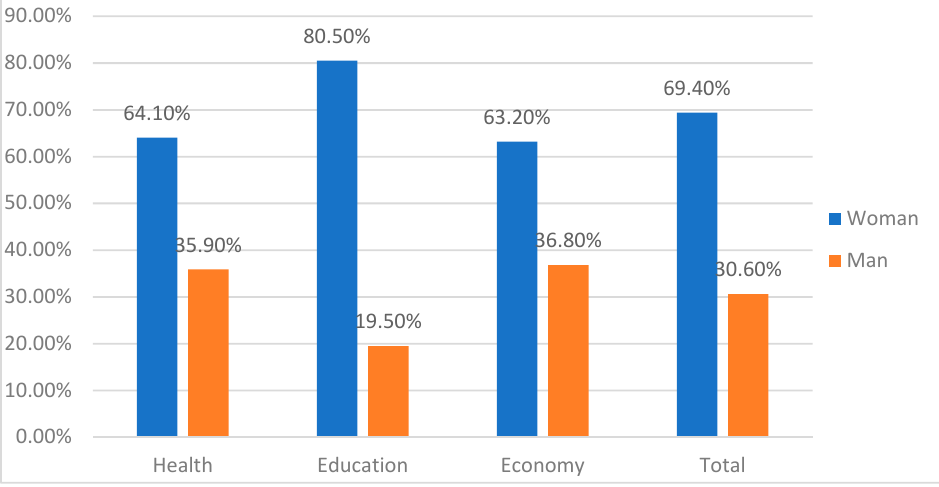
Figure 1. Characteristics of the sample according to sex and sector.